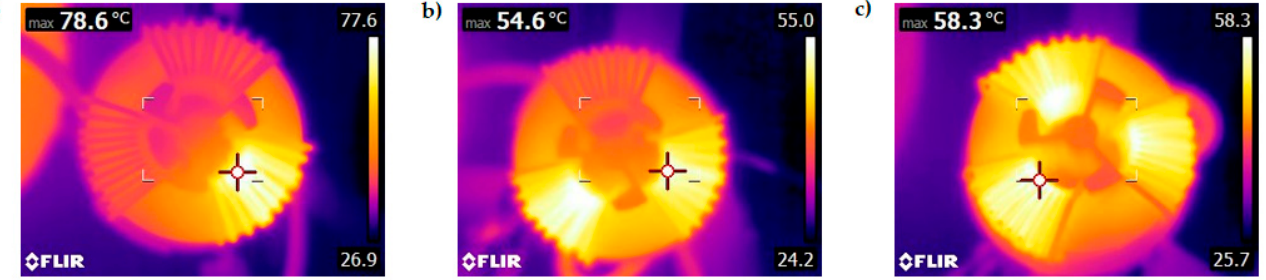
Figure 10. Thermograms illustrating the temperature distribution in the inductor when the current flows through one winding ( a ), two windings connected in series ( b ), and three windings connected in series ( c ).